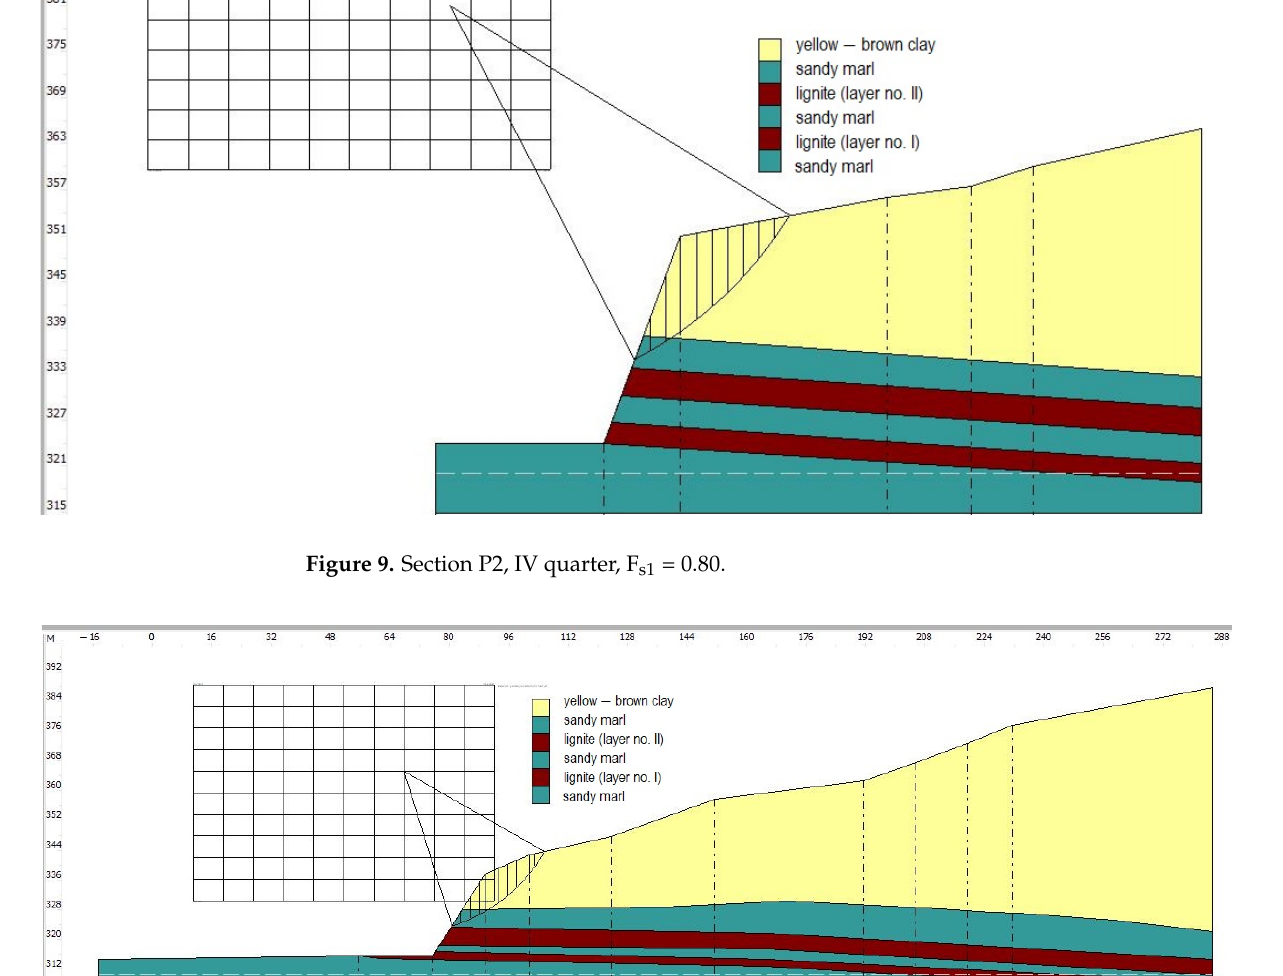
Figure 10. Section P4, IV quarter, F s1 = 1.01.